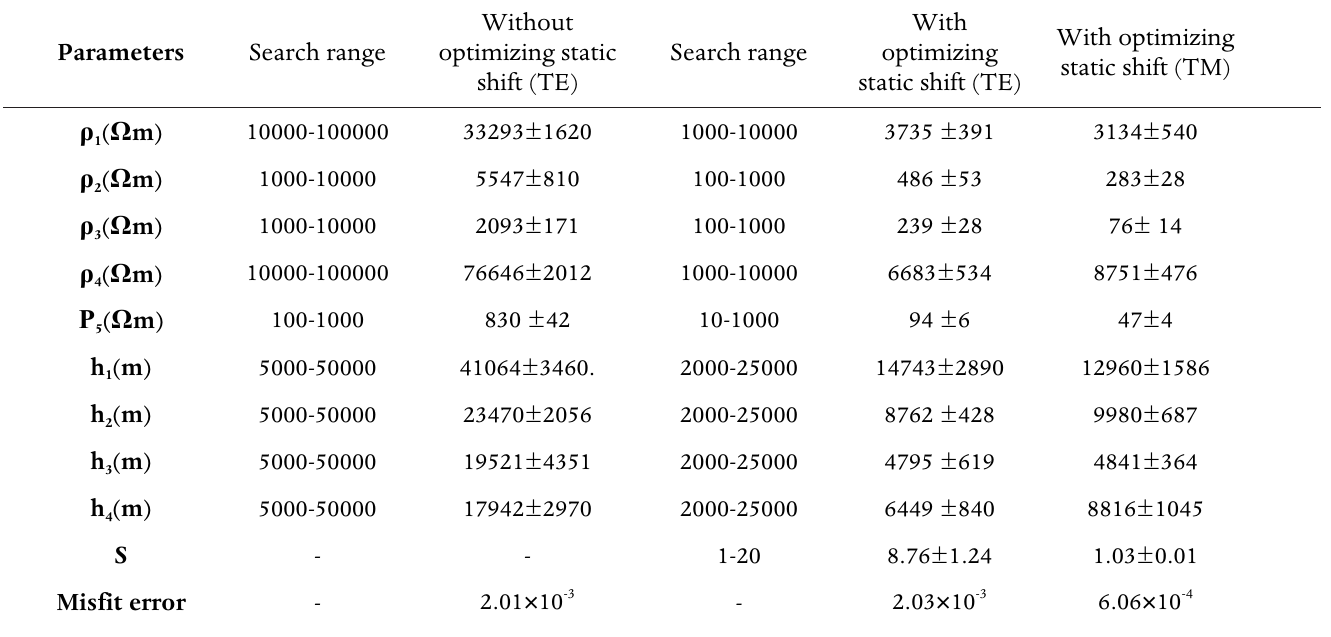
Table 8. Field data: inversion results without and with optimization of static shift. TE, transverse electric mode; TM, transverse magnetic